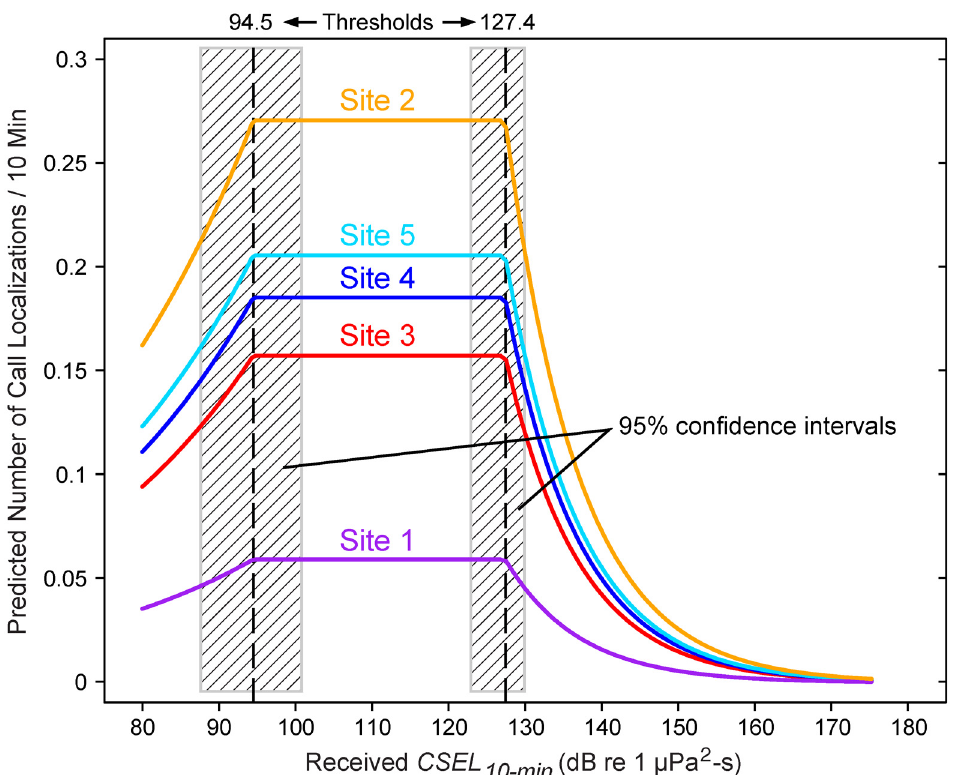
Fig 8. Threshold estimates from Poisson regression model, for all sites and all years combined. The model uses a cumulative sound exposure level calculated over 10-min periods ( CSEL 10-min ). The threshold estimates are 94.5 and 127.4 dB re 1 μ Pa 2 -s, respectively. Hatched areas are the 95% confidence intervals. Different sites had different predicted call localization rates per 10-min interval. See text for more